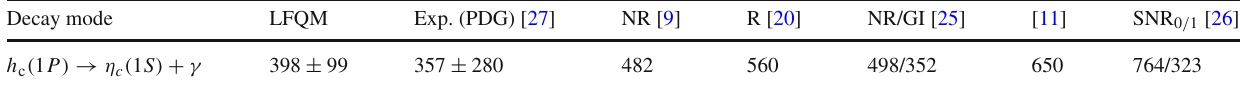
Table 1 Decay width (in units of keV) of h c ( 1 P ) → η c ( 1 S ) + γ in the light-front quark model, denoted LFQM, as compared with experi- mental data from [27], denoted exp.(PDG) and predictions from other theoretical models, including non-relativistic potential model (NR) [9,11,25], relativistic quark model (R) [20], the Godfrey–Isgur poten-